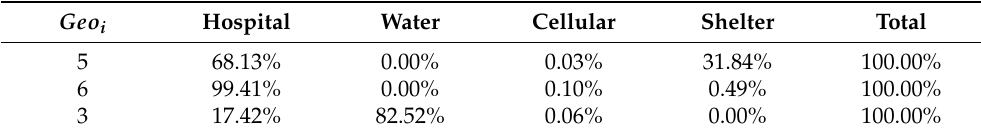
Figure 6. Microgrid locations from solution of P 2. Table 12. Percentage of power